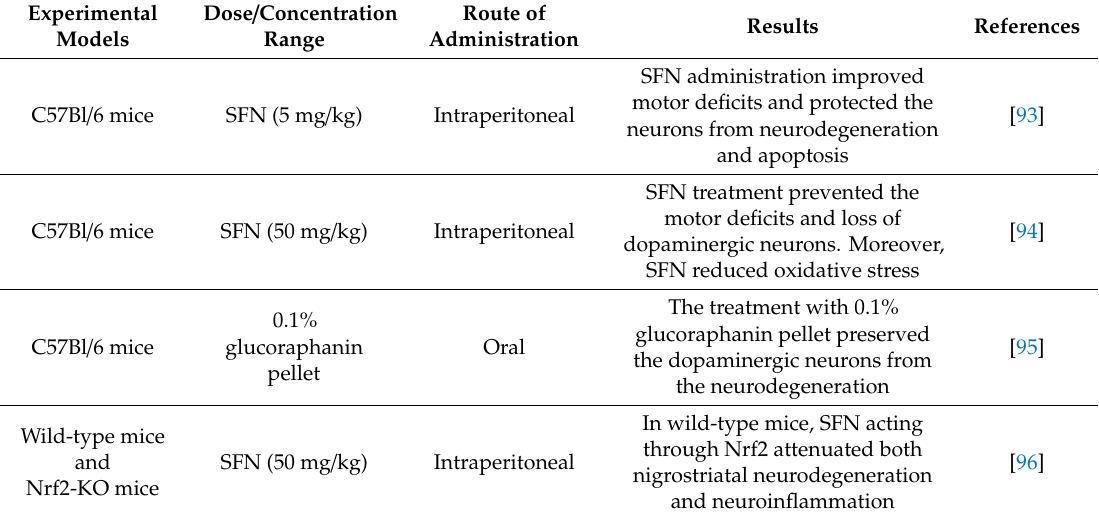
Table 4. The table summarizes in vivo studies that evaluate the e ff ects of SFN in PD. In particular, we described the models utilized, the dosage, the type of administration, and the